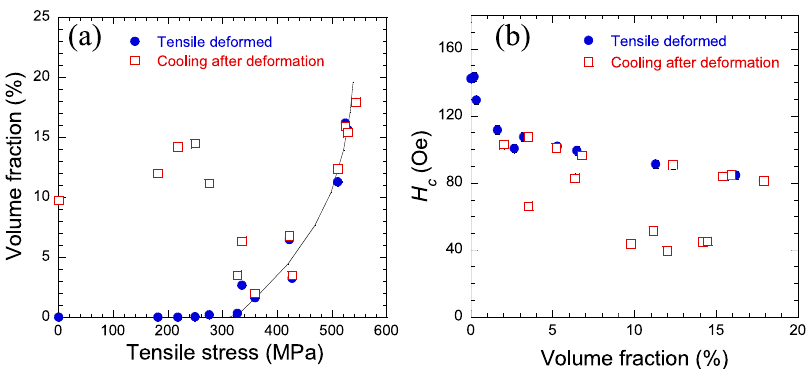
Figure 1. ( a ) Volume fraction of α′ -martensites as a function of tensile stress. ( b ) Coercivity as a function of volume fraction. The solid and open symbols denote the data before and after cooling at 77 K for five minutes.